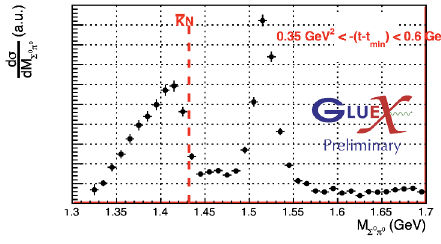
Figure 3. Preliminary results for the di ff erential cross-section measurement of γ p → K + Σ 0 π 0 in three bins of momentum transfer 2 . The Λ (1405) and Λ (1520) − t = − ( p − p K + ) beam are clearly identifiable as two peaking structures. The Λ (1405) shows a very much, non-Breit-Wigner shape with a sharp drop at the ¯ KN